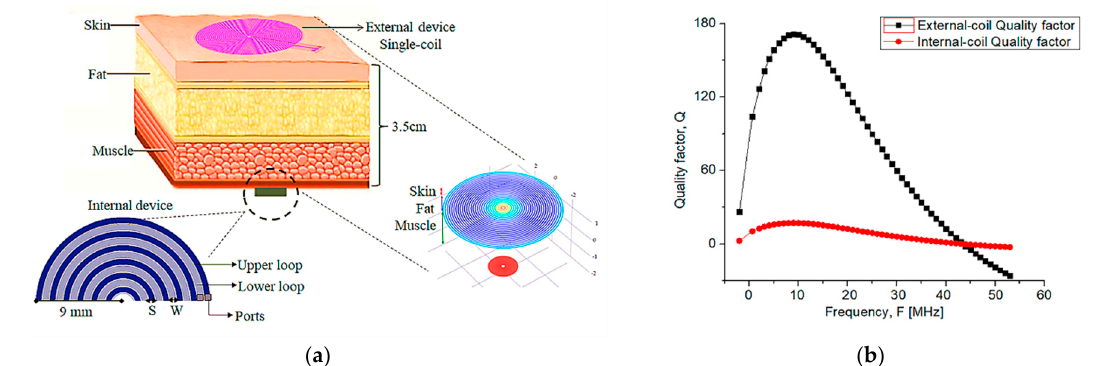
Figure 1. ( a ) Scheme showing the inductive coupling across the biological tissue and ( b ) quality factor over a wide frequency range for both designed inductive